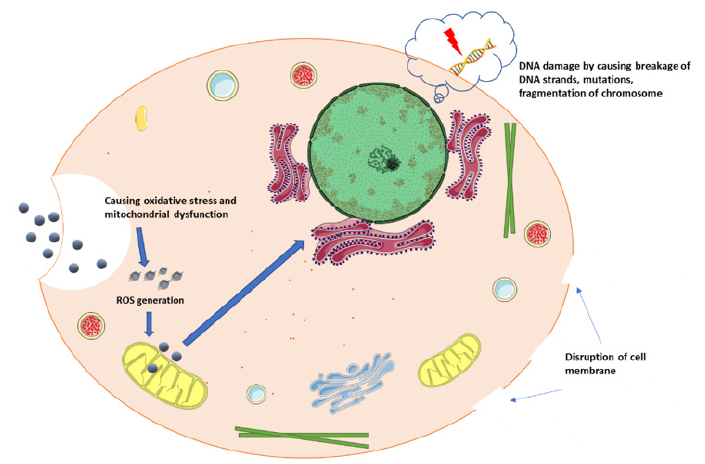
Figure 1. Mechanism of nanoparticles as oxidants (inspired from Khanna et al. [37]).